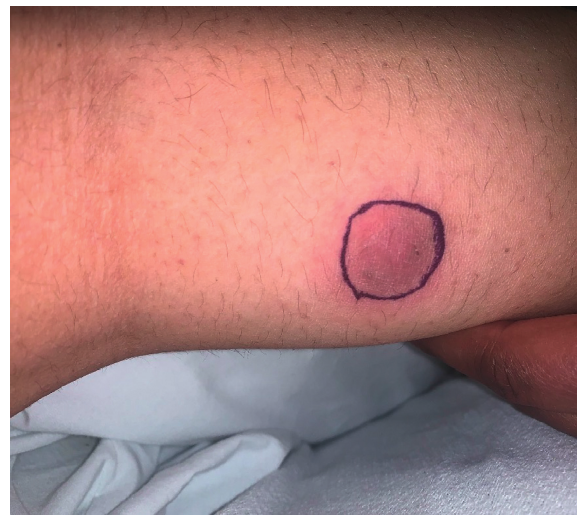
Figure 1: Violaceous skin nodule on posterior right lower leg, outlined with surgical marker to track